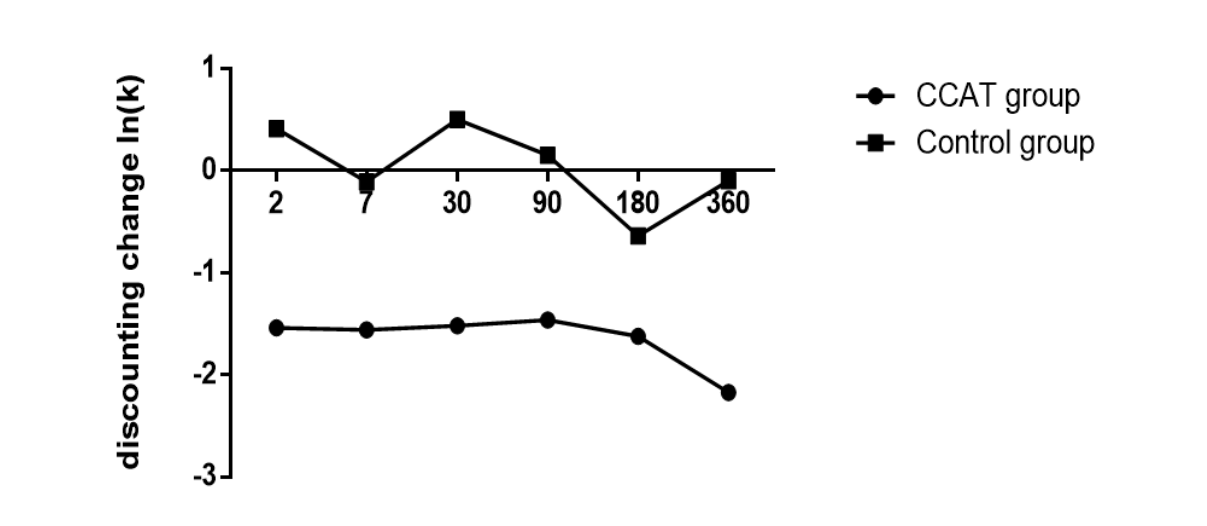
Figure 9. Discounting change ln(k) before and after computerized cognitive addiction therapy (CCAT) training. Change in discounting ln(k) for participants in CCAT and control groups, calculated as posttraining minus pretaining. Negative values indicate a decrease in discounting. The values 2, 7, 30, 90, 180, and 360 were delayed times in the delay discounting